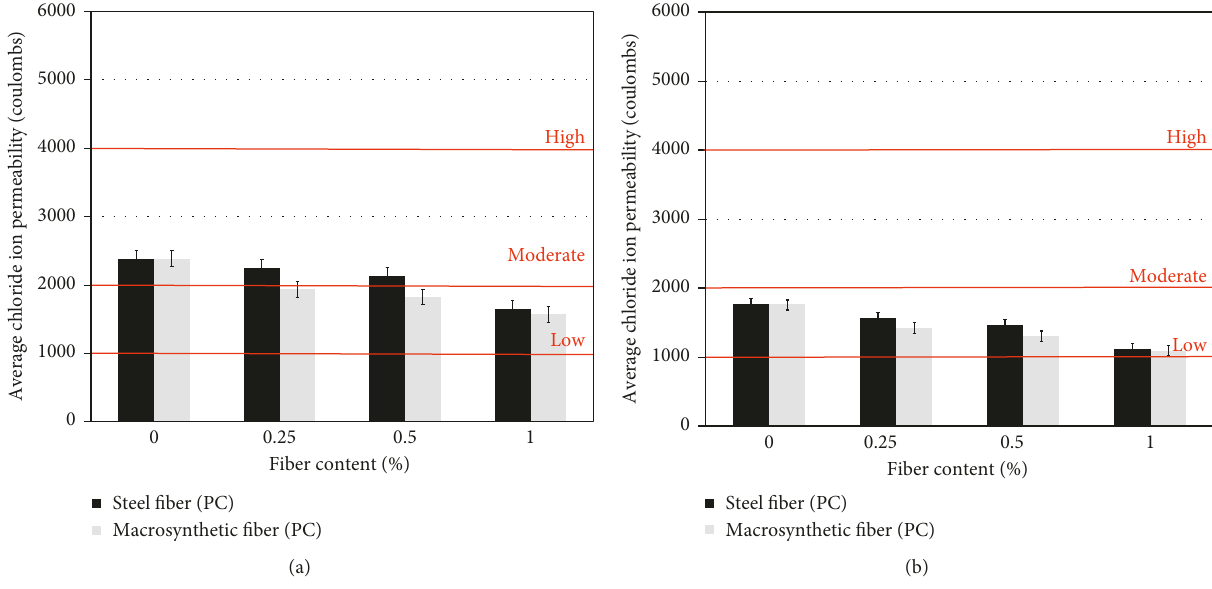
Figure 14: Chloride ion penetration of PC segments with reinforcing types. (a) 40MPa. (b) 60